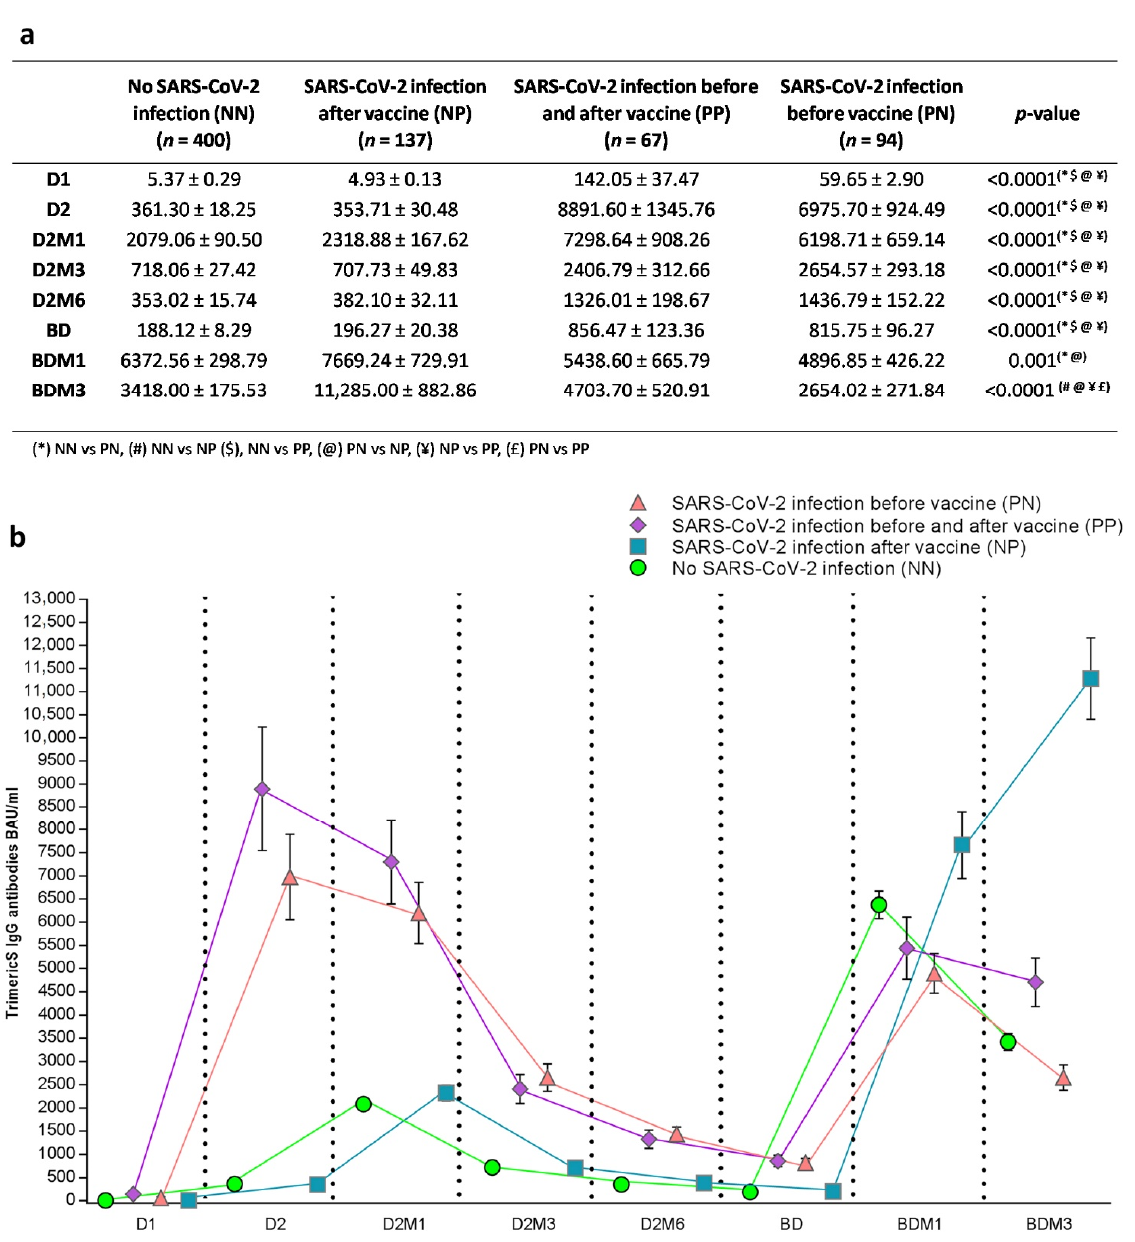
Figure 3. Anti-Trimeric Spike IgG geometric mean titer ( a ), and dynamic ( b ) before and after booster vaccination according to SARS-CoV-2 infection status (mean ± SE). The nonparametric Kruskal– Wallis test was used for comparison of continuous values between groups. D1, dose 1; D2, dose 2; D2M1, 1 month after dose 2; D2M3, 3 months after dose 2; D2M6, 6 months after dose 2; BD, booster dose; BDM1, 1 month after booster dose; BDM3, 3 months after booster dose; and SARS-CoV-2, severe acute respiratory syndrome-coronavirus-2.